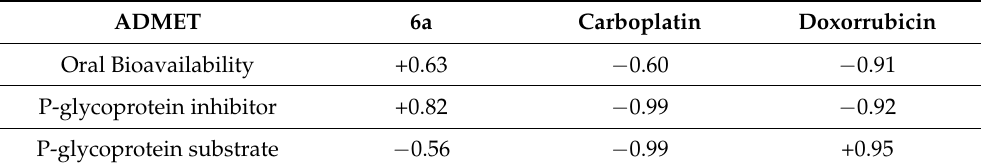
Table 5. Properties analyzed in admetSAR. The properties analyzed were oral bioavailability, sub- strate and P-gp inhibitor. The analysis was performed with compound 6a and the chemotherapeutic agents, carboplatin and doxorubicin as